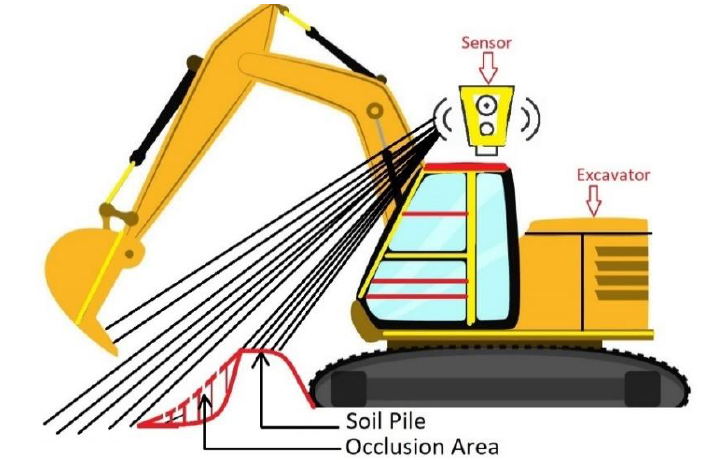
Figure 2. An example of an occlusion area: A pile on the ground blocks the sensor vision that hinders detection of the occluded area.